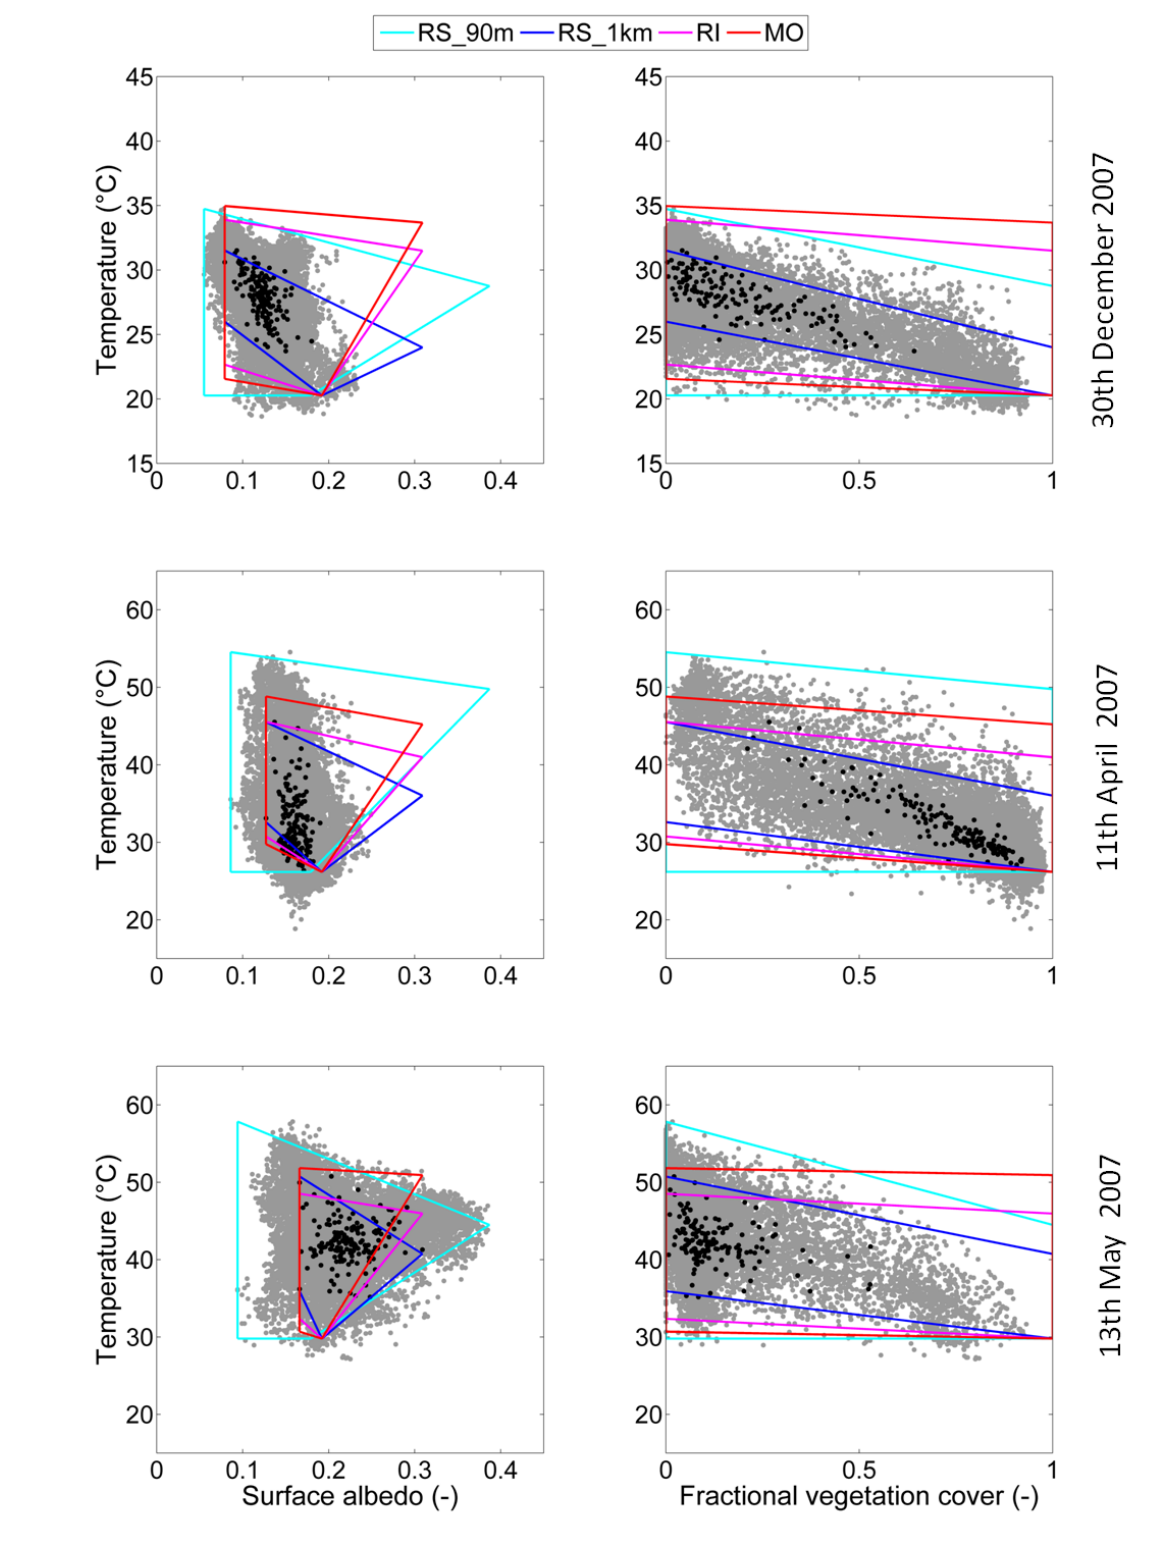
Figure 10. The LST − α and LST − f spaces corresponding to 1-km resolution data vg (black dots) and 90-m resolution data (grey dots) are overlaid with the polygons built using Tends_RS_1km (blue), Tends_RS_90m (light blue) and the Tends_EBsoil for the RI (magenta) and MO (red) aerodynamic resistance. Results are shown over the Yaqui area (30 December, 11 April and 13 May,